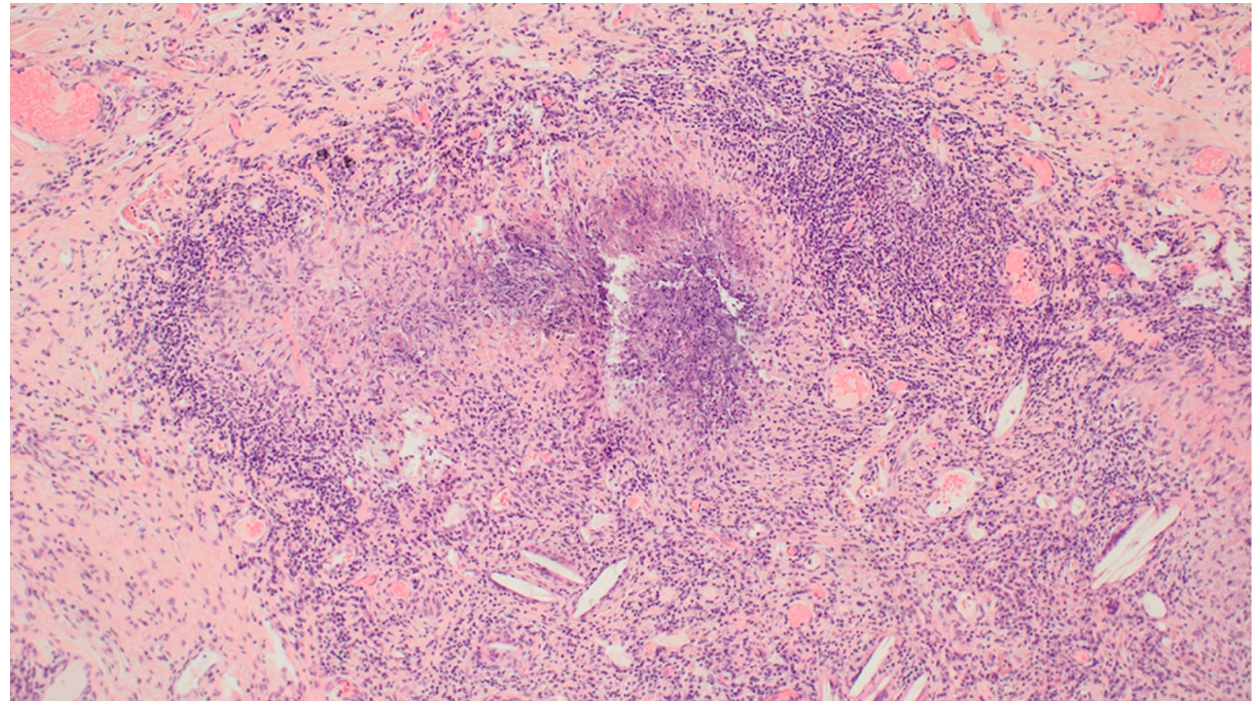
Figure 6. VATS biopsy from the right lung’s middle lobe: GPA necrotizing granuloma: necrotizing granulomatous inflammation and cholesterol clefts. The necrosis is basophilic, with geographical morphology. Magnification: ×10. HE stain.